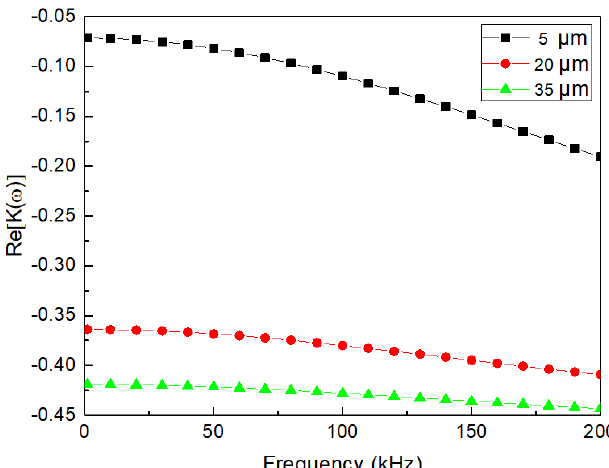
Figure A10. The Re [ K ( ω )] of PS over frequency under the medium conductivity of σ m = 0.001 S/m .